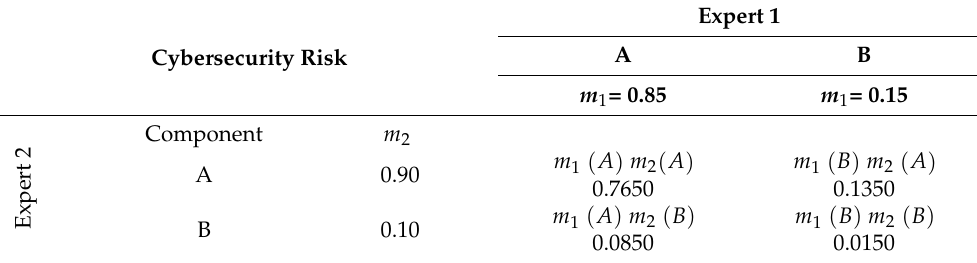
Table 5. Dempster combination of Expert 1 and Expert 2 for cybersecurity